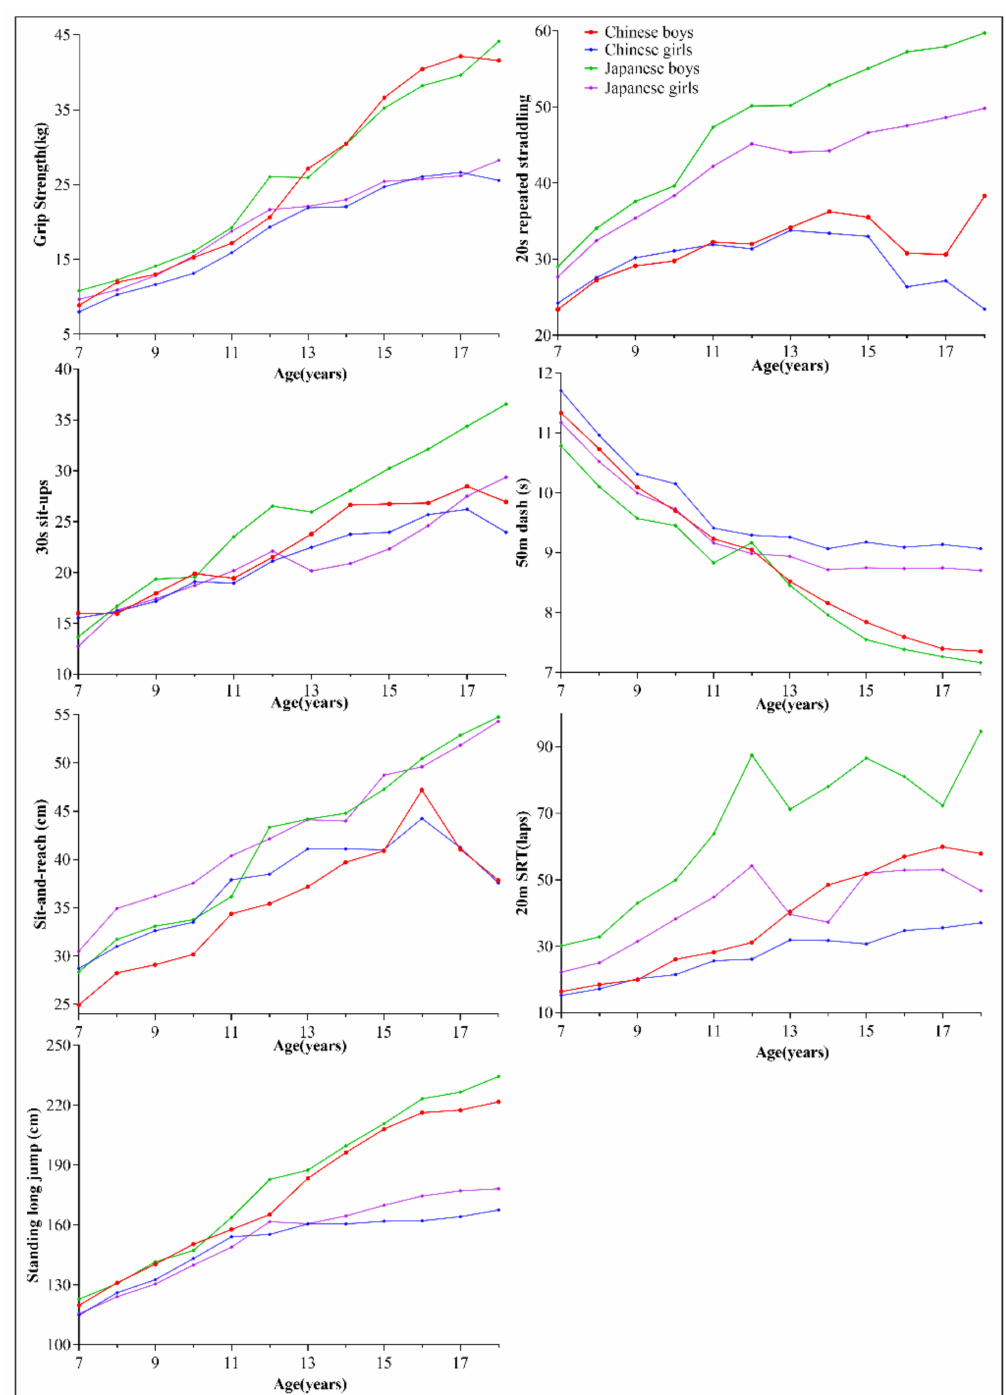
Figure 1. Age trends by gender of seven physical fitness items for children and adolescents aged 7–18 years in China and